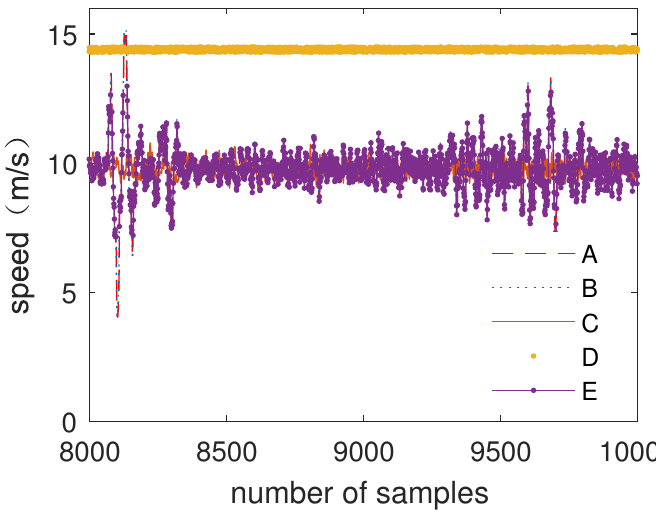
Figure 13. Speed data processing with one error input.